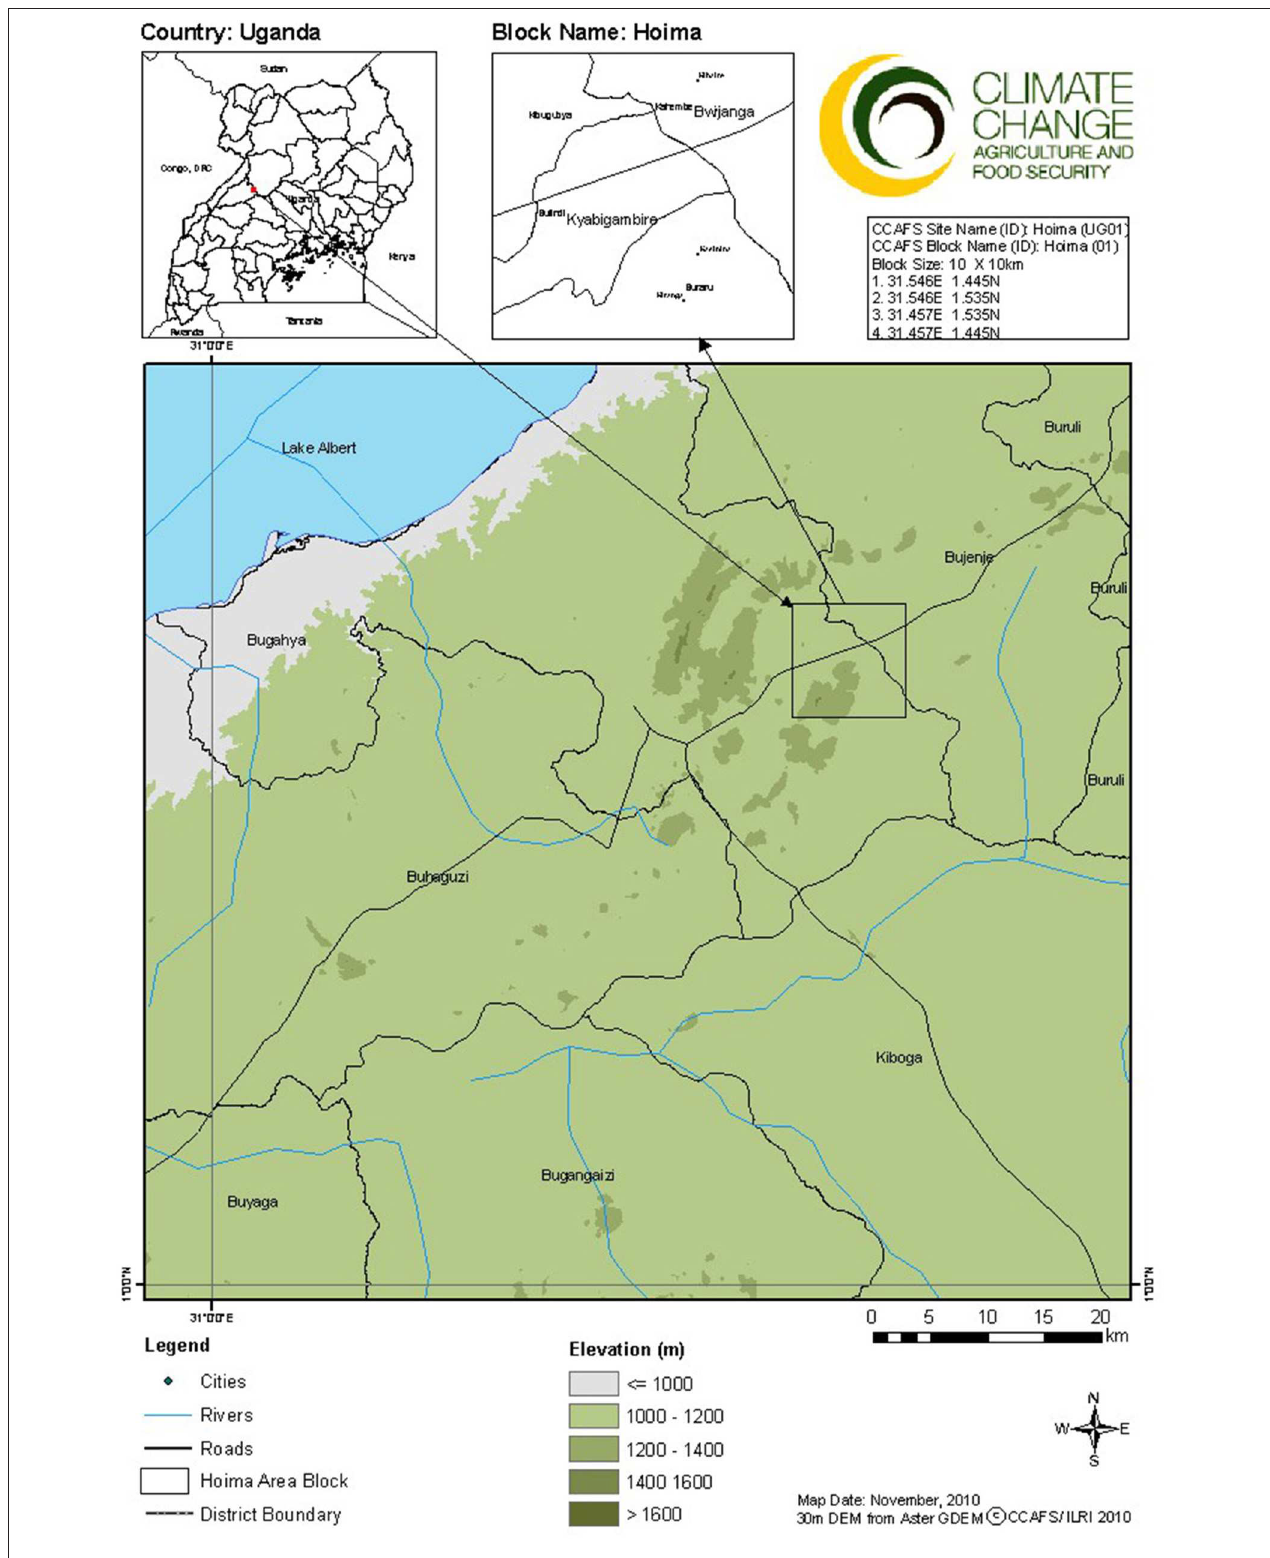
FIGURE 1 | Location of Hoima study site. Source: Mubiru and Kristjanson (2012).